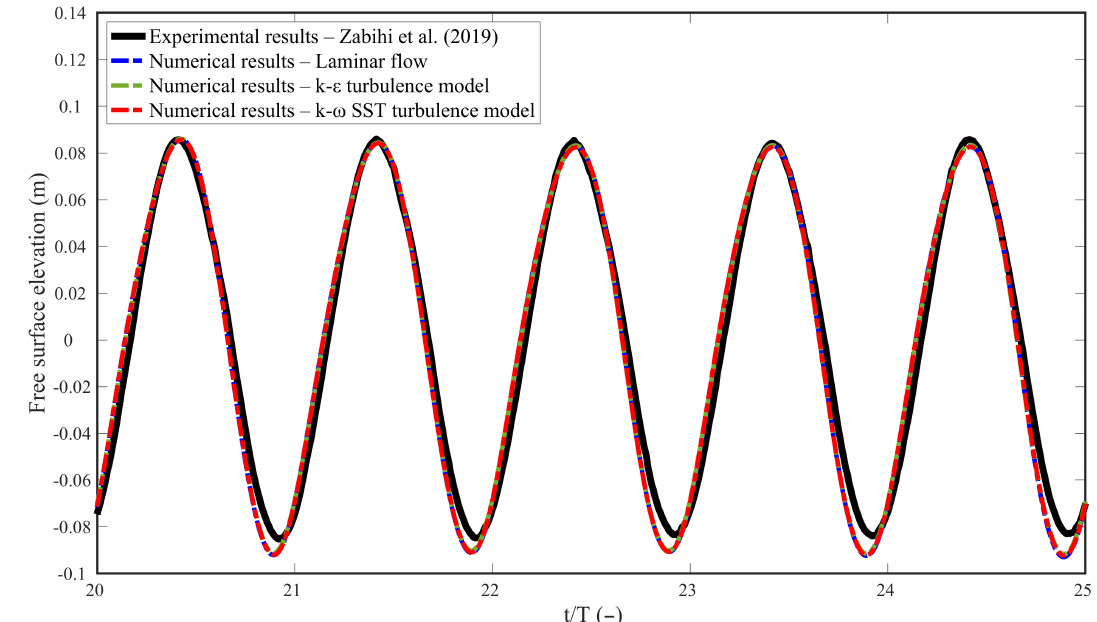
Figure 14. Free surface elevation at wave gauge WG1, located outside the hydropneumatic chamber. Experimental versus numerical results.